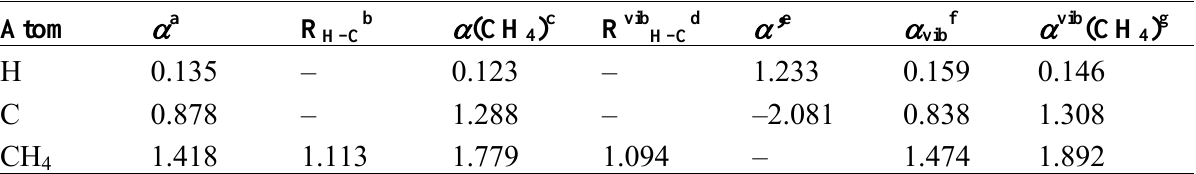
Table 1. Vibrational corrections for methane effective atomic and mean molecular